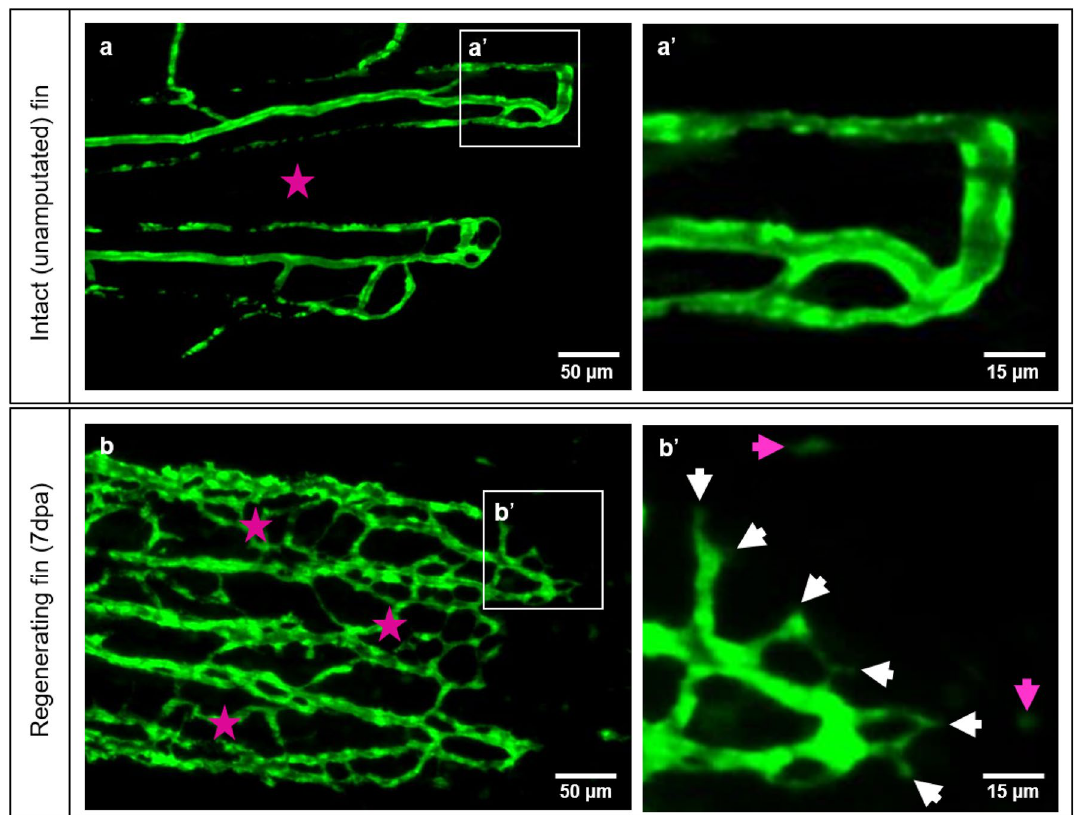
Figure 1. Vascular organization of intact caudal fin vs. early regeneration. Organization of tissue compartments in the intact caudal fin ( a ) versus the regenerating fin ( b ), at 7dpa. a/a’ display smooth and hierarchically well- organized blood vessels (green - reporter transgenic zebrafish line) in which intraray segments do not contain any vessels (asterisk) and capillary sprouts are not detectible ( a’ ). ( b/b’ ) display dense, well-interconnected capillary meshwork. The intraray region (purple asterisks) contains bridging vessels and at the expanding vascular front multiple sprouts ( b’ , white arrows) and migrating - endothelial cells (purple arrows). Images are acquired by fluorescent reflected light